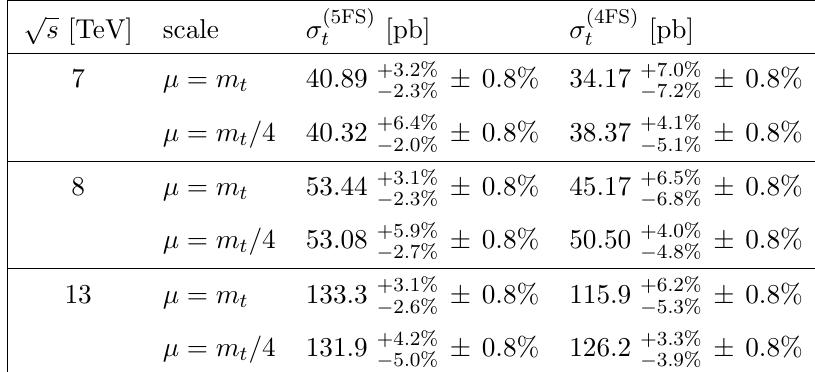
Table 3 . Predictions for single top production at NLO in the 5FS and the 4FS. The 5FS (4FS) predictions have been computed using the corresponding NLO 5FS (4FS) input NNPDF3.1 PDF set. The (cid:12)rst uncertainty quoted is the upper and lower missing higher-order uncertainty of the predictions, which is obtained by taking the envelope of the 7-point scale variation in which we vary the scales in the range 1 = 2 (cid:20) (cid:22) f ; (cid:22) r < 2. The second uncertainty represents the PDF uncertainty.